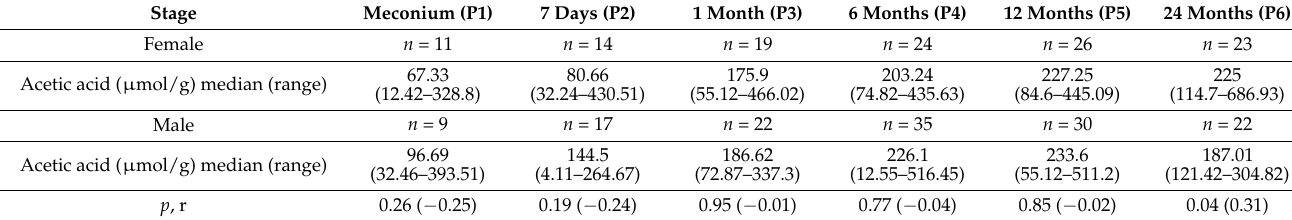
Table 9. Acetate content over time by sex.